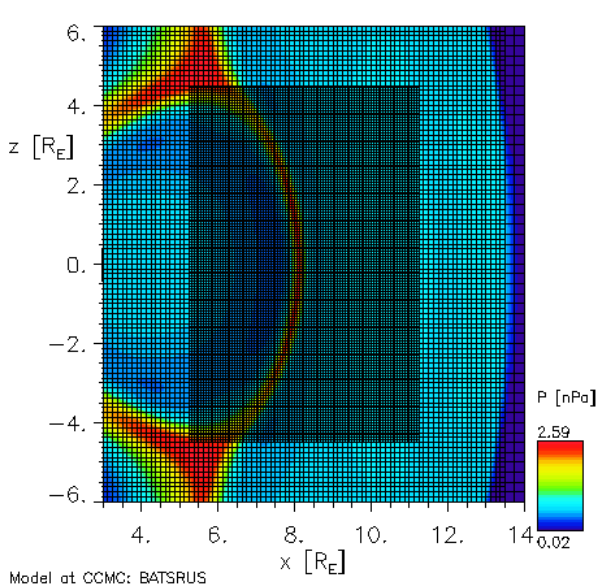
Fig. 1. Plasma pressure for the x - z plane at y = 0 at the beginning of the simulation. Earth is located at (0, 0, 0). The finer resolution of 1/16 R E is located around the magnetopause boundary layer. At this time the magnetopause subsolar point is located at x = 8 R E and z = 0.